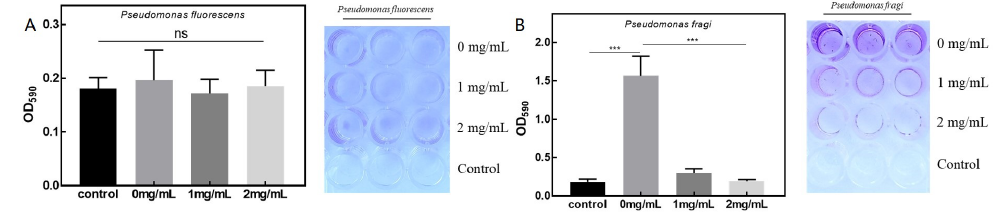
Figure 9. Antibacterial effects of D. algida on the generated biofilm of the target Pseudomonas , where ( A , B ) are the absorbance values of P. fluorescens and P. fragi , respectively, under different MIC. The data are shown as mean ± SD ( n = 3), *** p <